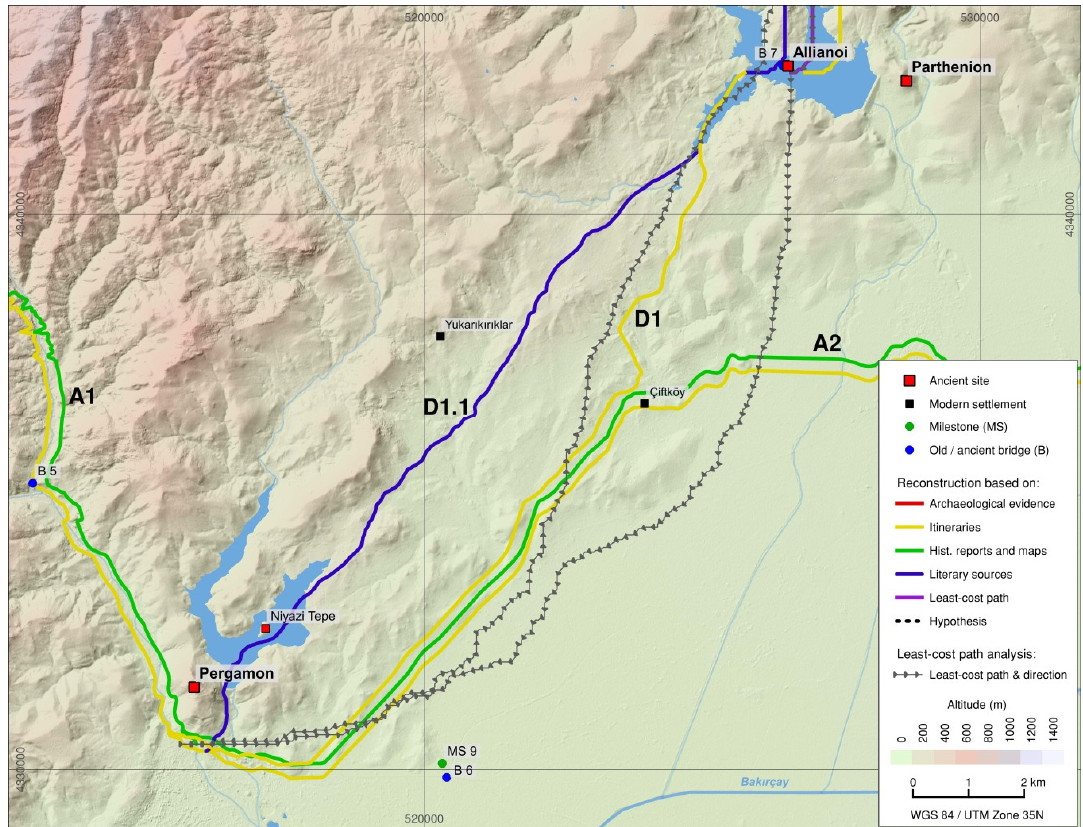
Figure 15. Sections between Allianoi, Parthenion, and Pergamon of the calculated least-cost paths and reconstructed routes between Ergasteria and Pergamon.